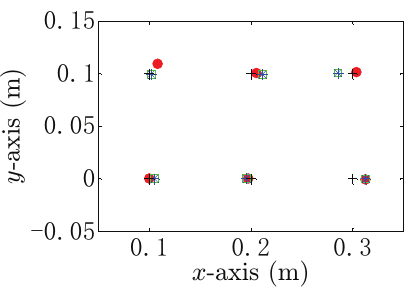
Figure 12. The estimated position by using the BEM model, simplified model and Rasnow